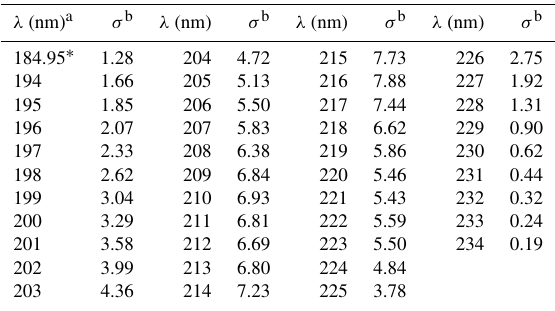
Table 1. UV absorption cross sections for isoprene from this work.